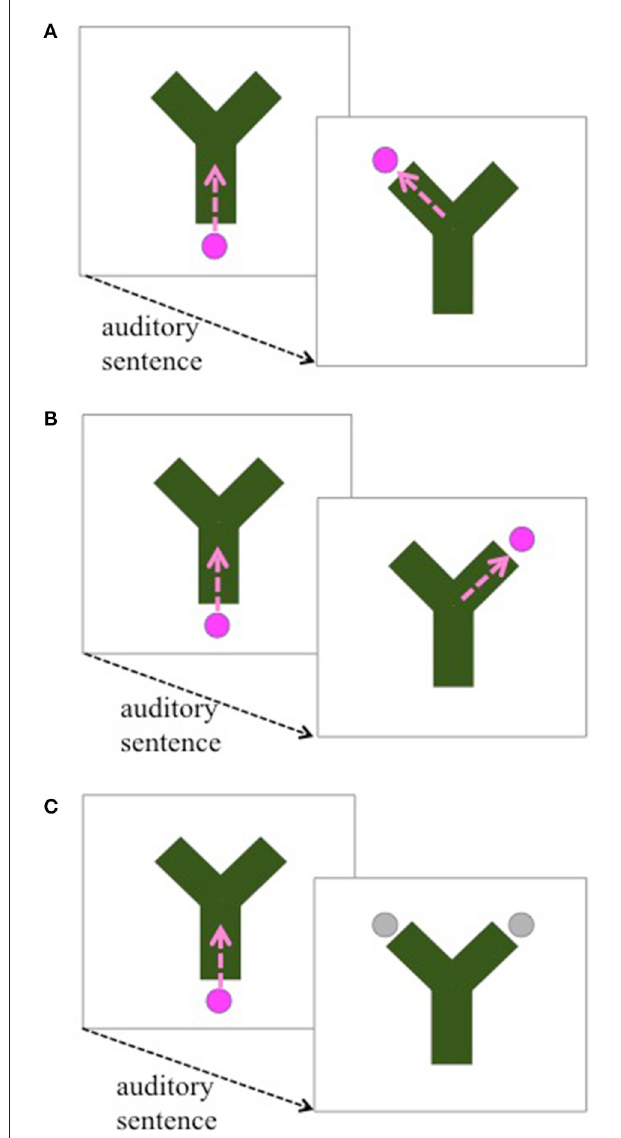
FIGURE 1 | Start and end points of the videos accompanying each auditory stimulus sentence. In “click”-trials, Two- and Three Role sentences (75% of the trials), the ball entered the green tube (path shown by the dashed arrow), and either re-emerged on the left side, or the right side (A,B ). There was a consistent match between side and number of roles (counterbalanced across participants). In “guess”-trials (25% of remaining trials, including base and light verb constructions), the ball did not re-emerge; instead, participants had to guess where the ball would have landed if it had re-emerged by clicking on one of the two possible landing sites (C)